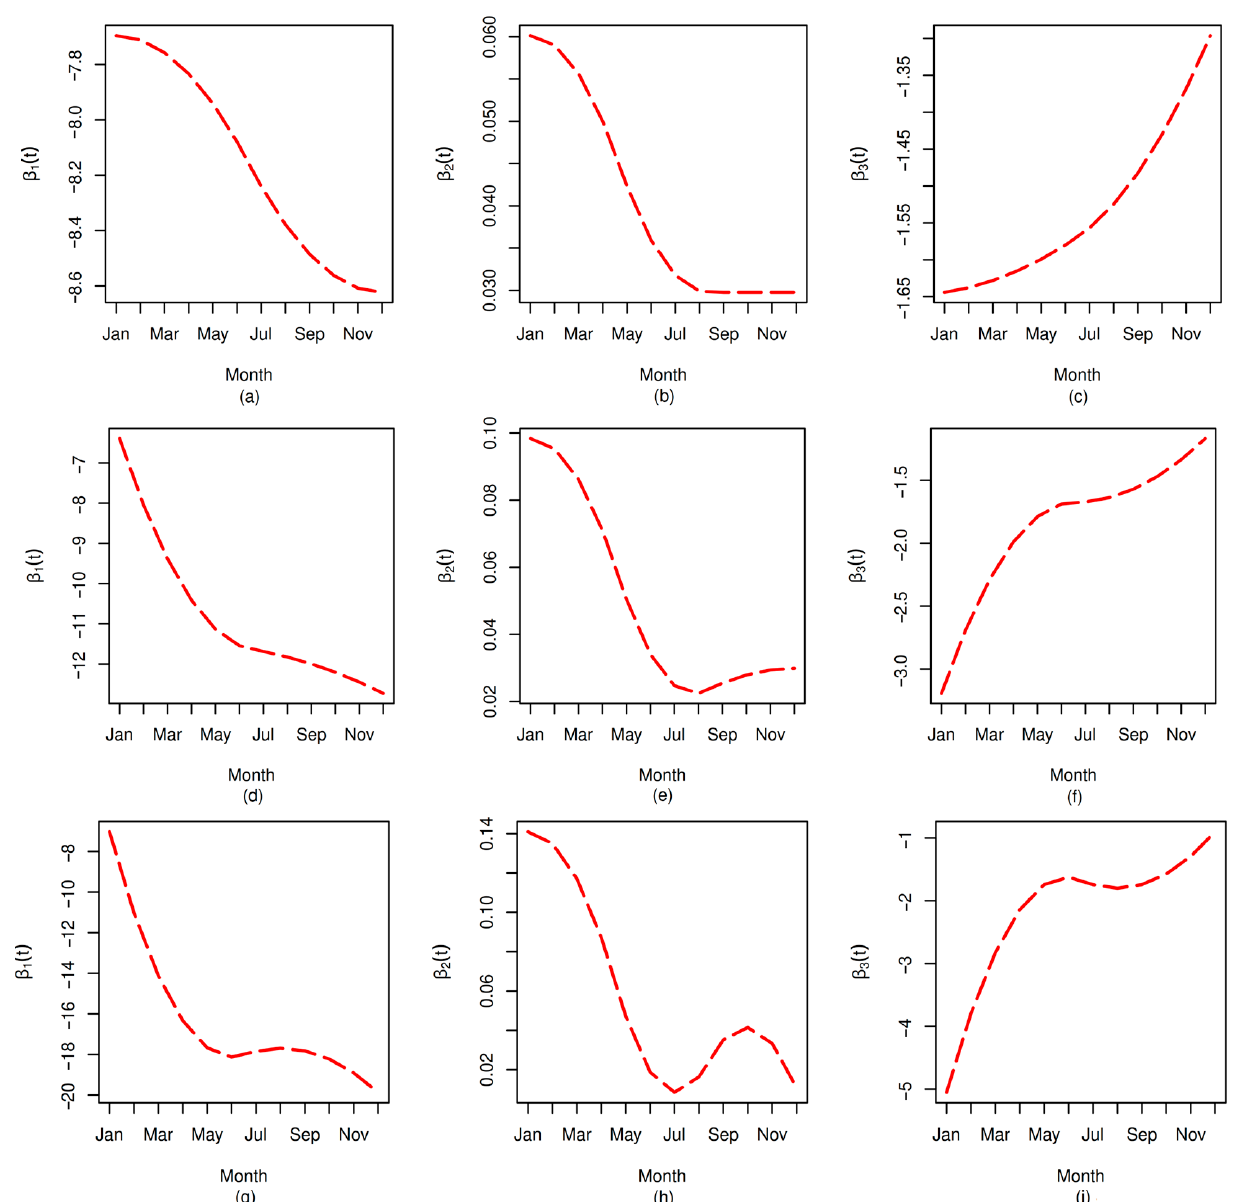
Figure 3. Coefficient plots of time variables for three quantile levels of dengue fever in Bandung city from 2017–2021 (( a ) Slope 1 for Quantile 25%, ( b ) Slope 2 for Quantile 25%, ( c ) Slope 3 for Quantile 25%, ( d ) Slope 1 for Quantile 50%, ( e ) I Slope 2 for Quantile 50%, ( f ) Slope 3 for Quantile 50%, ( g ) Slope 1 for Quantile 75%, ( h ) Slope 2 for Quantile 75%, ( i ) Slope 3 for Quantile 75%)